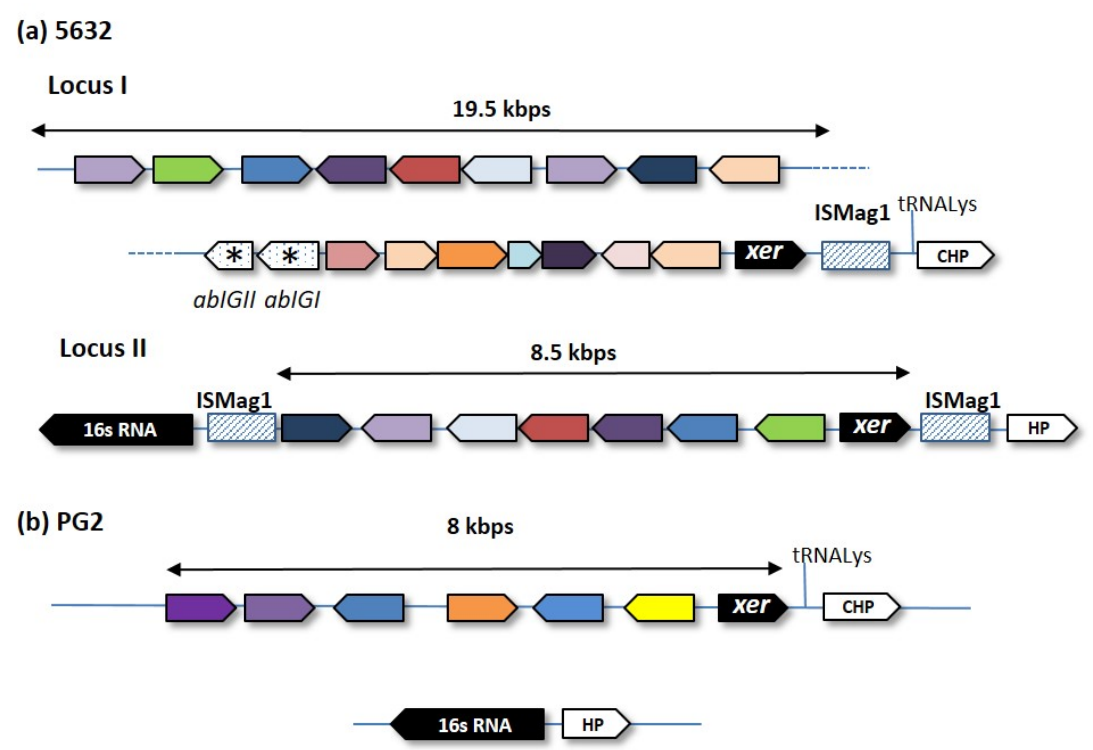
Figure 2. Comparison of M. agalactiae vpma loci of strain 5632 ( a ) with that of the PG2 T type strain ( b ). In PG2 T , the counterpart of 5632 locus-II is deprived of vpma genes. Large filled arrows represent Vpma CDSs, with each color representing individual Vpmas whose genes might occur in the two loci. The two non-Vpma-related CDSs ( abiG I and abiG I) only found in 5632 are indicated by an asterisk. IS Mag1 elements are indicated by hatched boxes. Schematics were approximately drawn to scale. HP—hypothetical protein; CHP—conserved hypothetical protein. Locus I of 5632 was split in two parts to fit into a portrait format but were indeed collinear, as indicated by the dotted lines. xer : genes encoding the tyrosine recombinase [20].